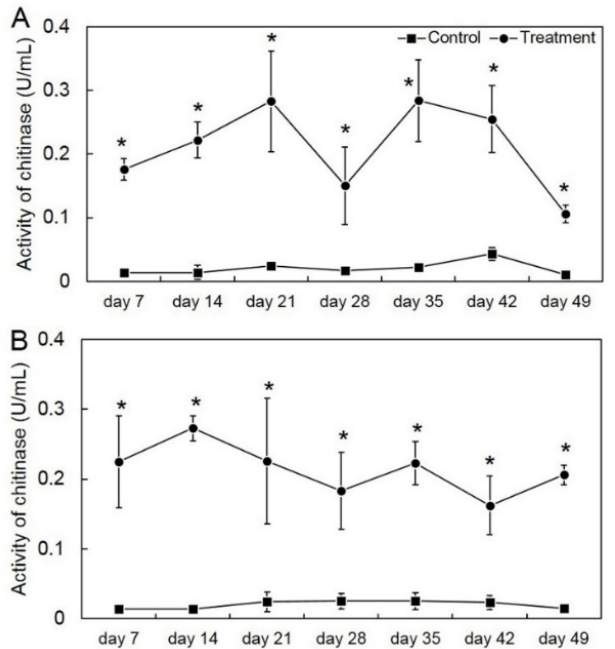
Figure 3. Activity of chitinase in the first crop ( A ) and second crop ( B ) through enzyme assay in Trichoderma asperelloides PSU-P1-treated muskmelon and control plants. * Indicates a significant difference between treatment and control according to Student’s t -test with p < 0.05.